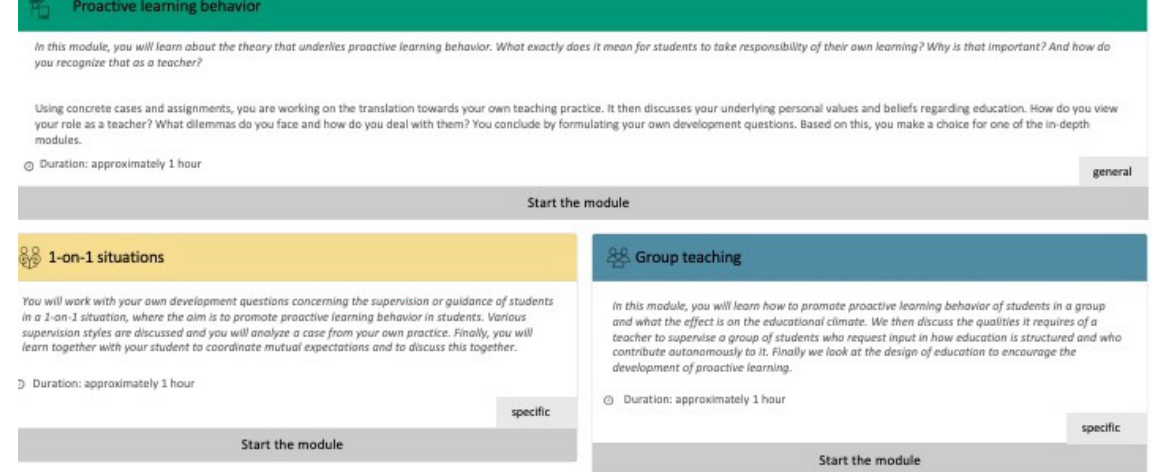
Figure 1: The three parts of the